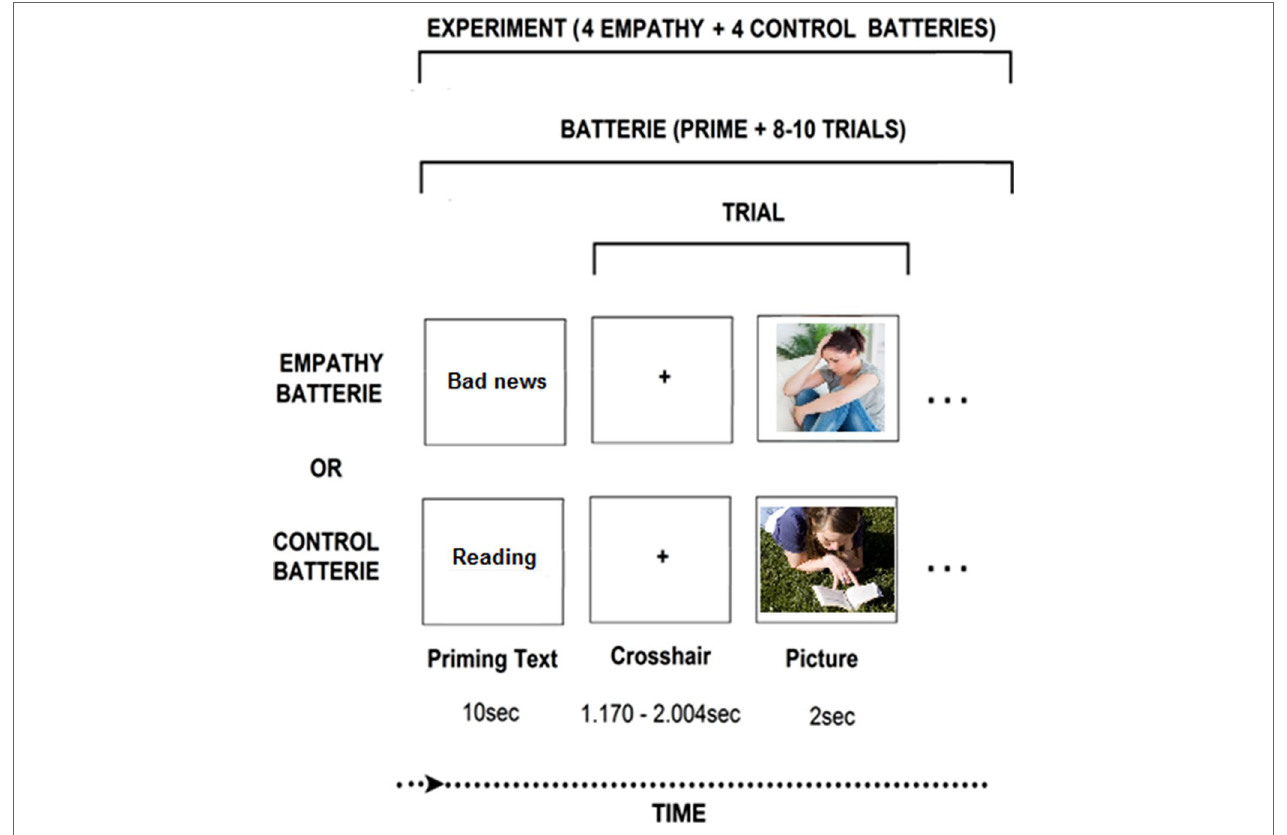
FIGURE 1 | Neuroimaging experimental design. The “bad news” photo: Wavebreak Media Ltd © 123RF.com. The “reading” picture: FreeImages.com/Ryan